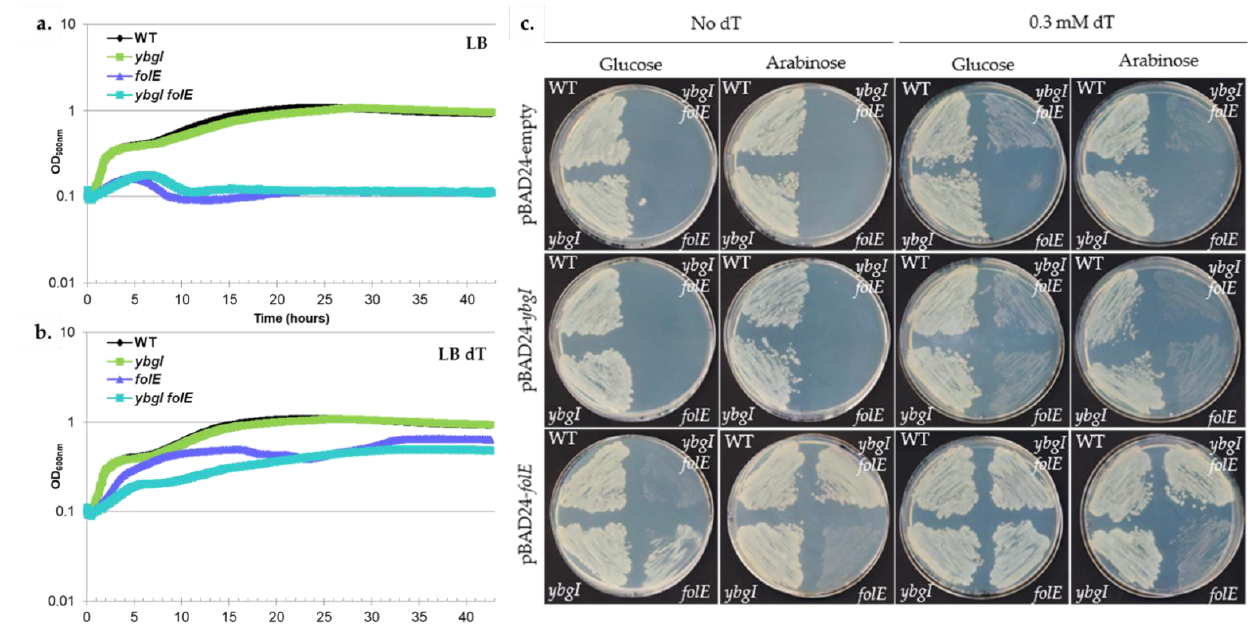
Figure 8. DUF34 of E. coli , ybgI , fails complementation in the absence of folE . Plates were imaged after 20 h of growth at 37 °C. ( a , b ) dT essentiality assay. WT, single mutants, and double mutant ( folE , ybgI ) strains have been grown at 37 °C in LB supplemented in the absence ( a ) or presence ( b ) or dT 0.3 mM. Each curve shown is averaged across 5 replicates. ( c ) dT essentiality complementation assay. WT, single mutants, and double mutant ( folE , ybgI ) strains, containing various derivatives of pBAD24 encoding for either E. coli YbgI or FolE, have been streaked on LB plates supplemented with Ampicillin 100 µg/mL in the presence of either 0.2% glucose for repression of the gene expression, or 0.2% arabinose for overexpression of the gene of interest, and in presence or absence of dT 0.3 mM.